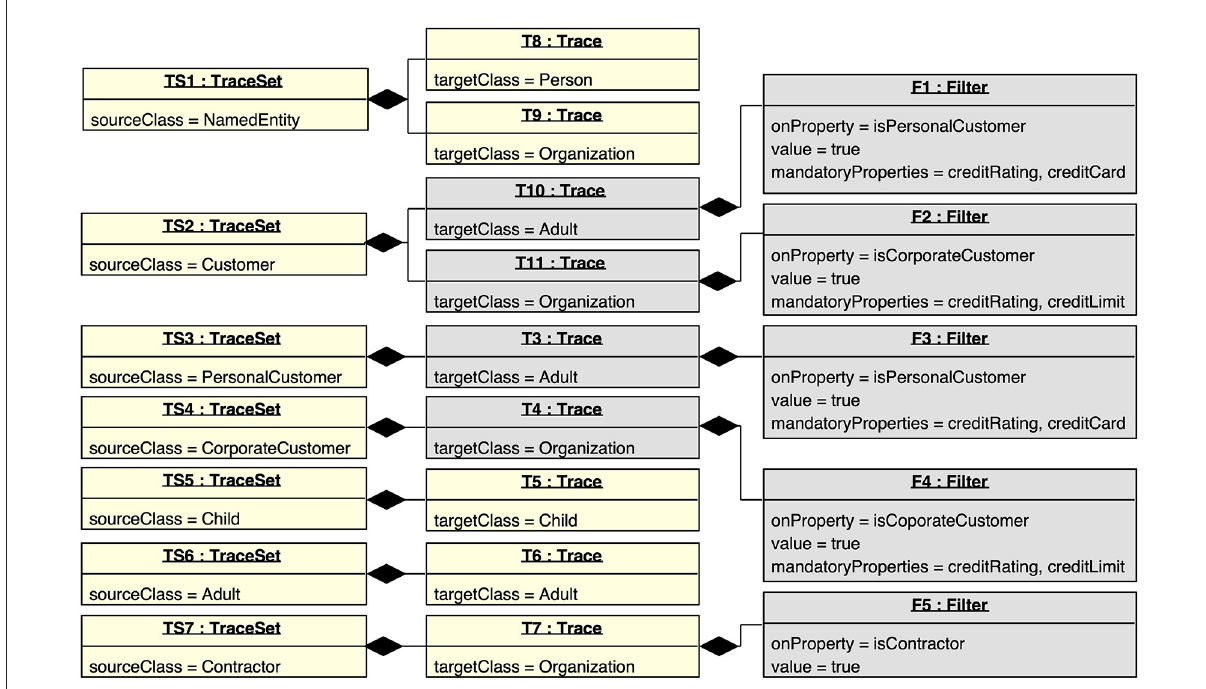
FIGURE9 Trace table after the lifting of PersonalCustomer , CorporateCustomer and Contractor .